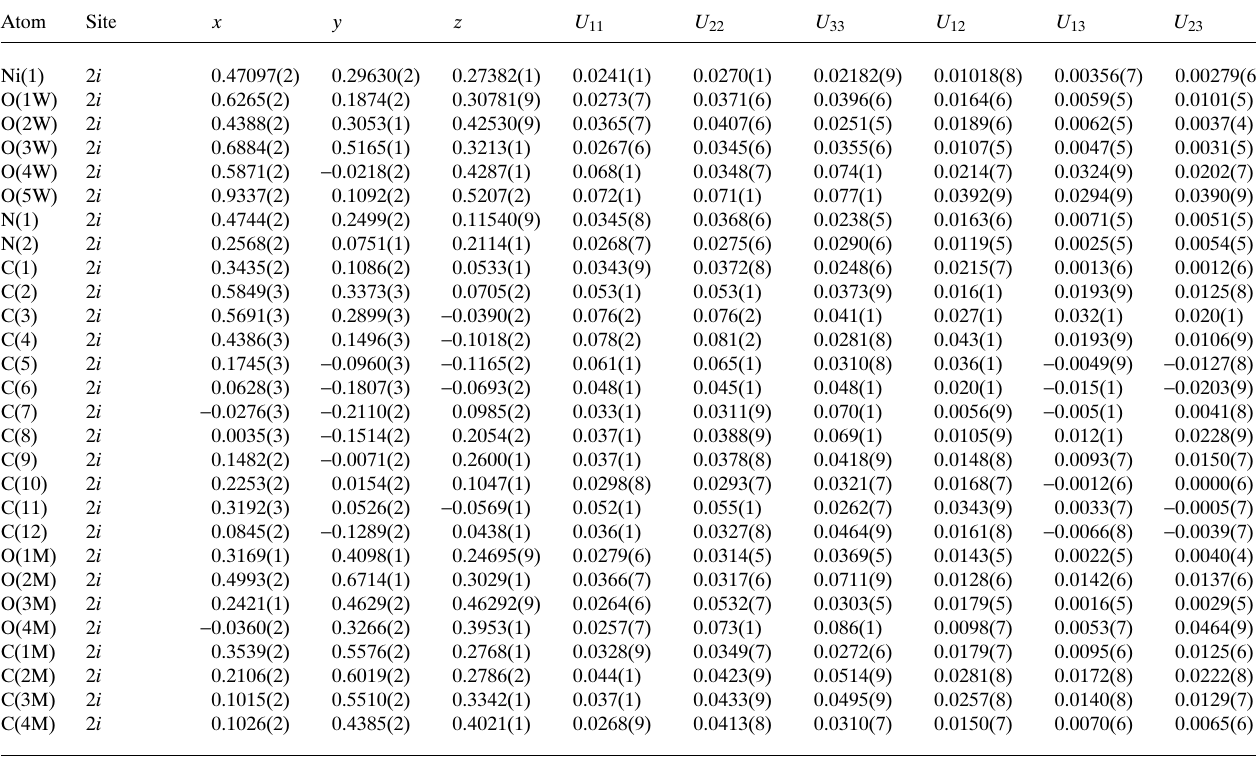
Table 3. Atomic coordinates and displacement parameters (in Å 2 ) .